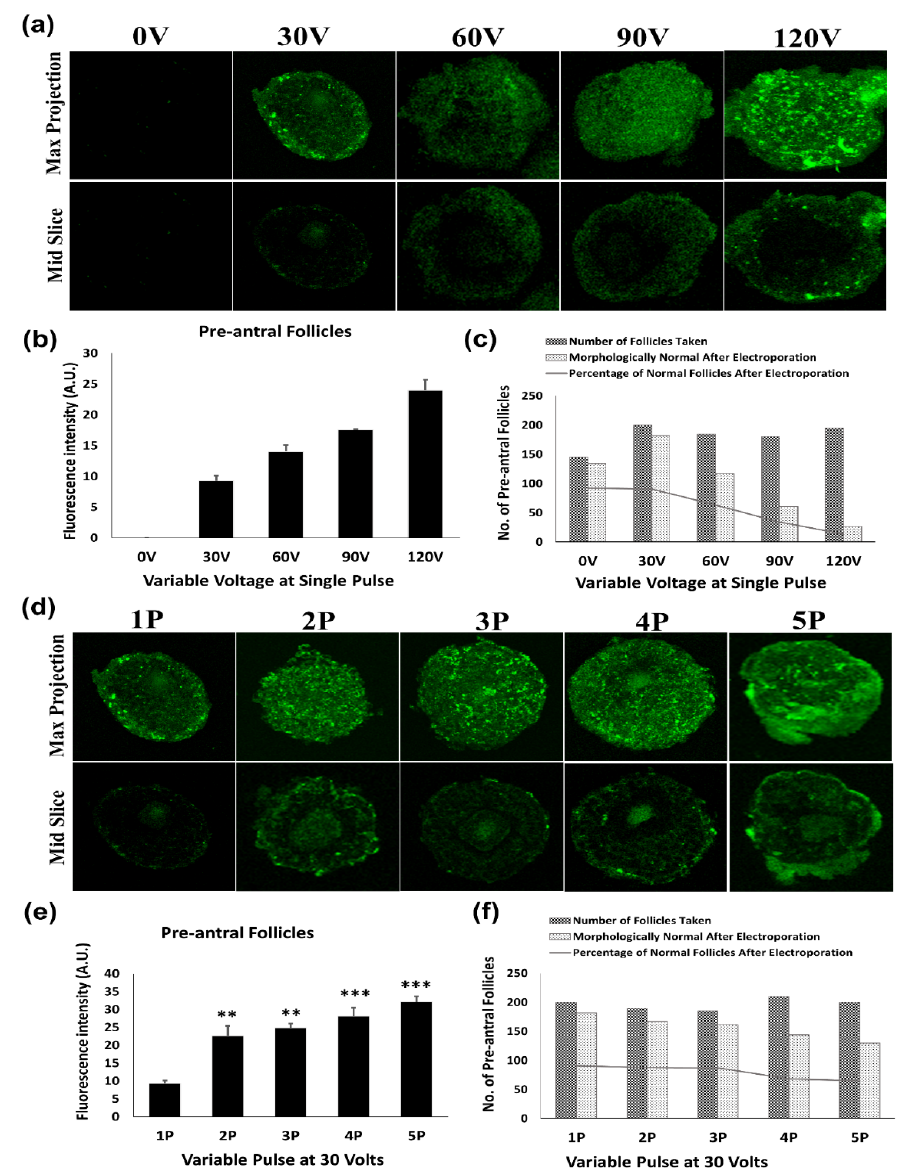
Figure 1. Photomicrograph depicts transfection efficiency of GFP through its fluorescence intensity in preantral follicles after electroporation. ( a , b ) Transfection of GFP increased gradually with increased voltage (30–120 V) within a single pulse. ( c ) However, this increased voltage caused deterioration in follicular morphology and reduced survival rate. ( d , e ) Consequently, multiple pulses of 30 volts at an interval of 10 s (1–5) were used; ( f ) where follicular morphology and survival was maintained until three consecutive pulses (i.e., 3 P of 30 V) were given with increased transfection efficiency. Beyond three pulses (4 and 5 P of 30 V), survival rate decreased ( χ 2 = 123.5, df = 8, p < 0.0001). Fluorescence intensity (arbitrary units) was quantified through ImageJ Software. ** p <0.01 and *** p < 0.001 reflect a significant difference as compared to the single pulse of 30 V. Original magnification of photomicrographs was ×